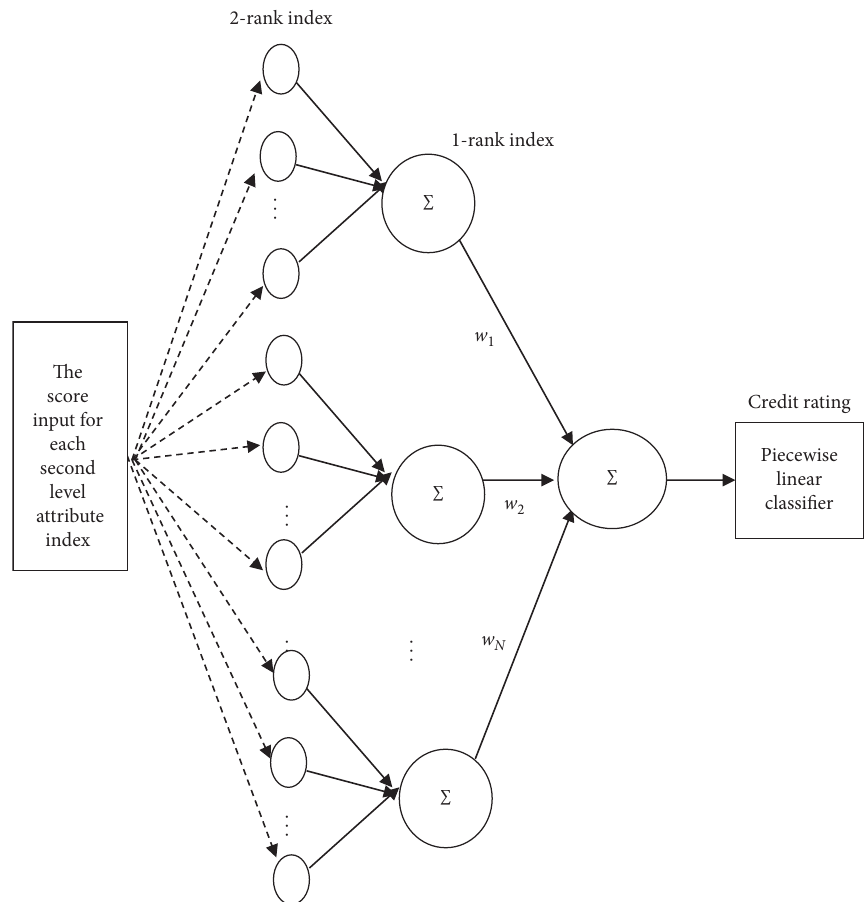
Figure 2: Farmer’s credit rating system based on three-layer unidirectional